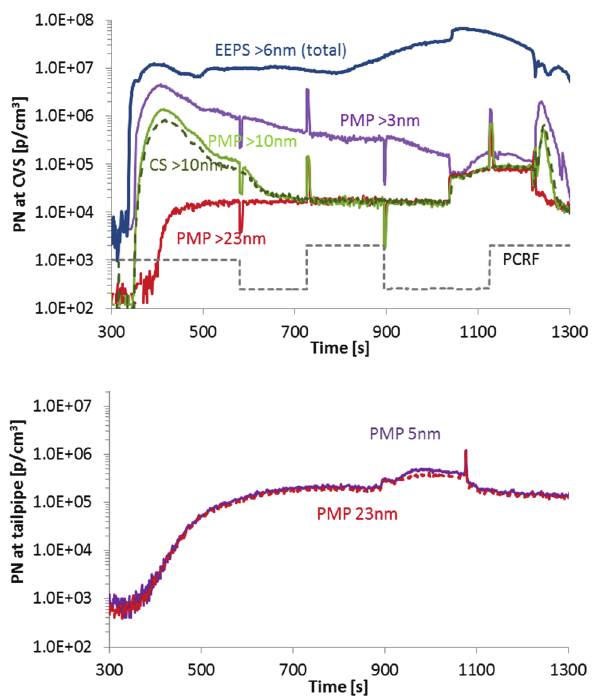
Fig. 3. PN emissions during triggered/forced regeneration with the vehicle parked. Upper panel: Measurements from the CVS. Lower panel: Meas- urements from the tailpipe (subsequent test) [25]